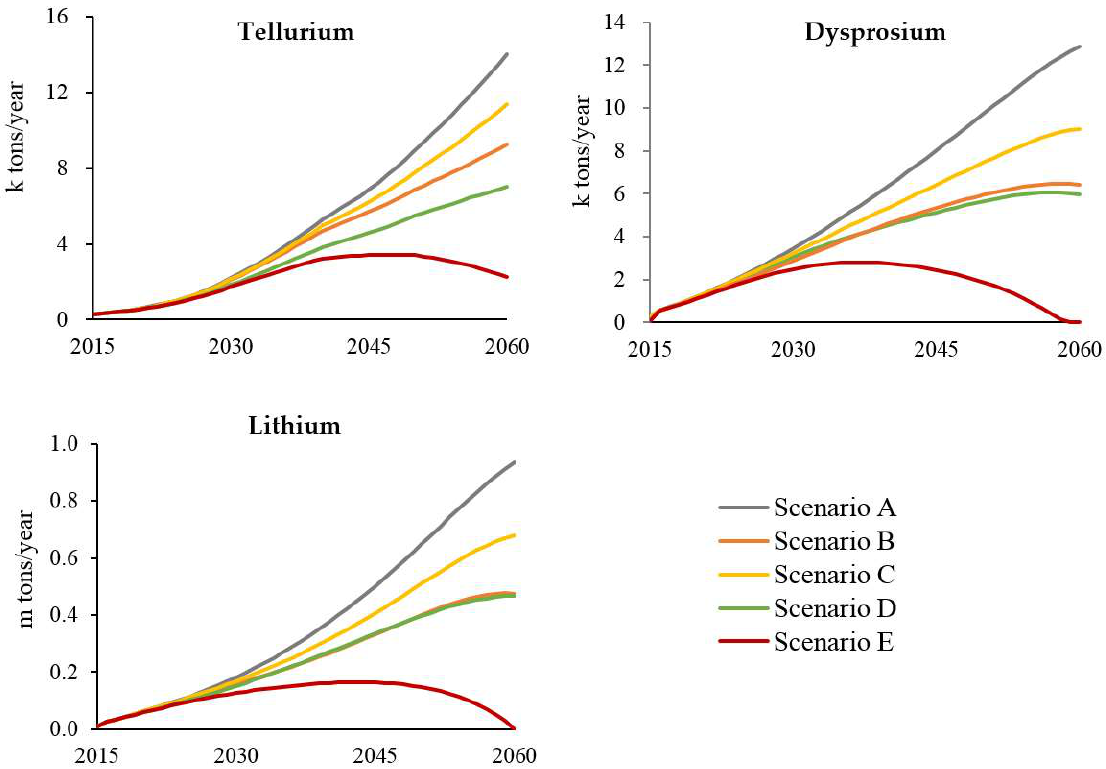
Figure 17. Annual primary demand for low carbon energy technology considering recycling and reduction of material intensity.